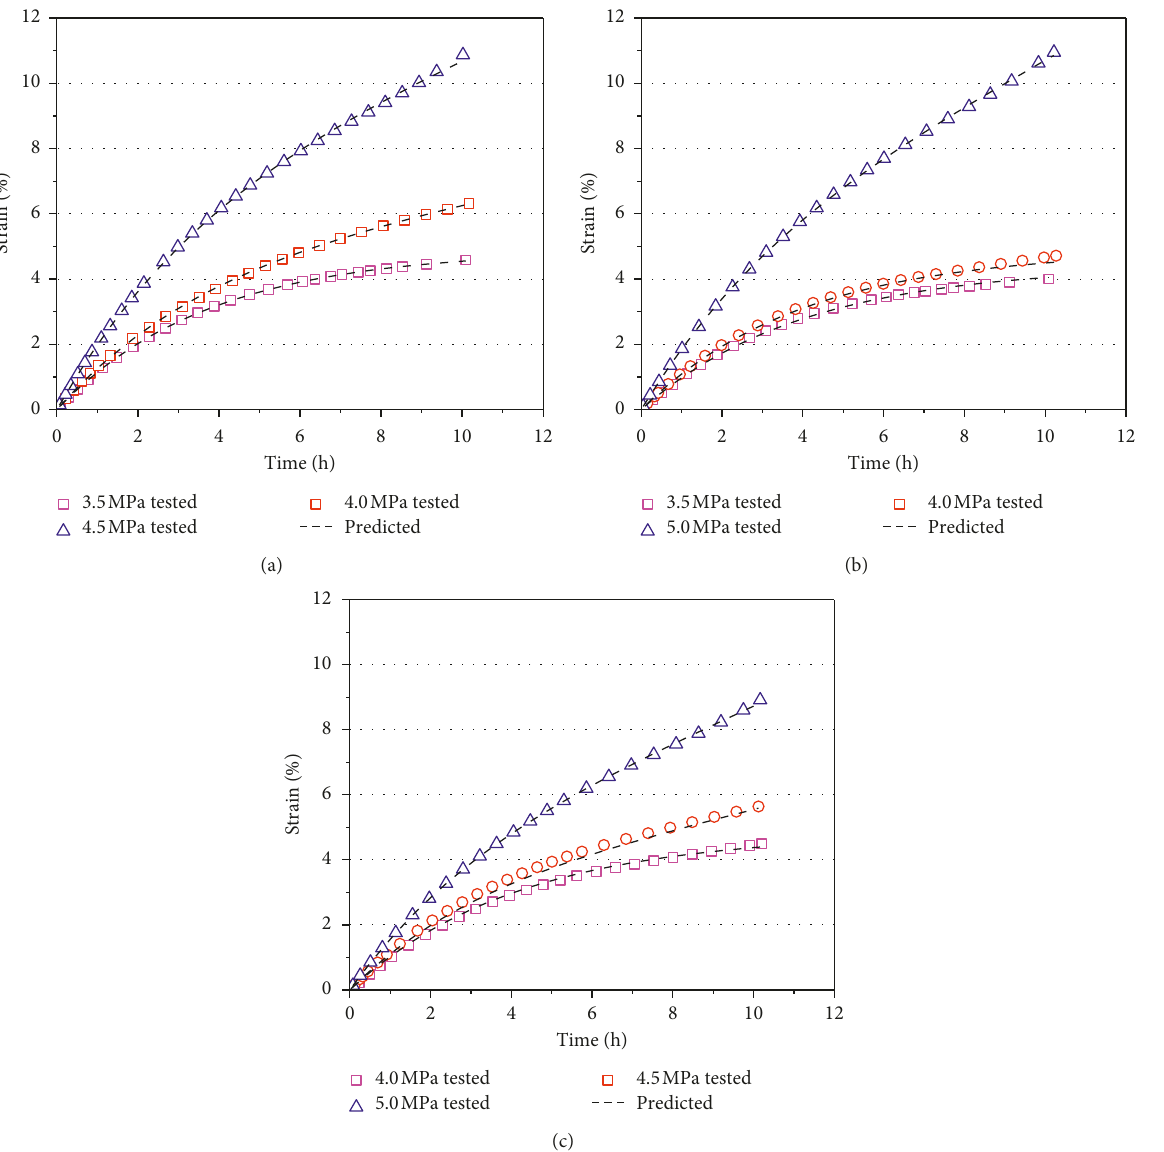
Figure 13: Comparisons between the experimental and calculation results ( σ